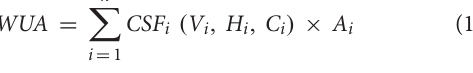
River. The grid was divided according to the boundary. Since a triangular grid can finely describe the shoreline conditions of the study area, the model adopted an irregular triangular grid. The grid size was determined according to the spatial distribution of the topography. According to the above principles and considering the calculation time, the total number of grid nodes was 12,854, the total number of cells was 23,845, the maximum area was 1580.2 m 2 , and the minimum area was 138.3 m 2 . The topography and grid generation are shown in Figure 3